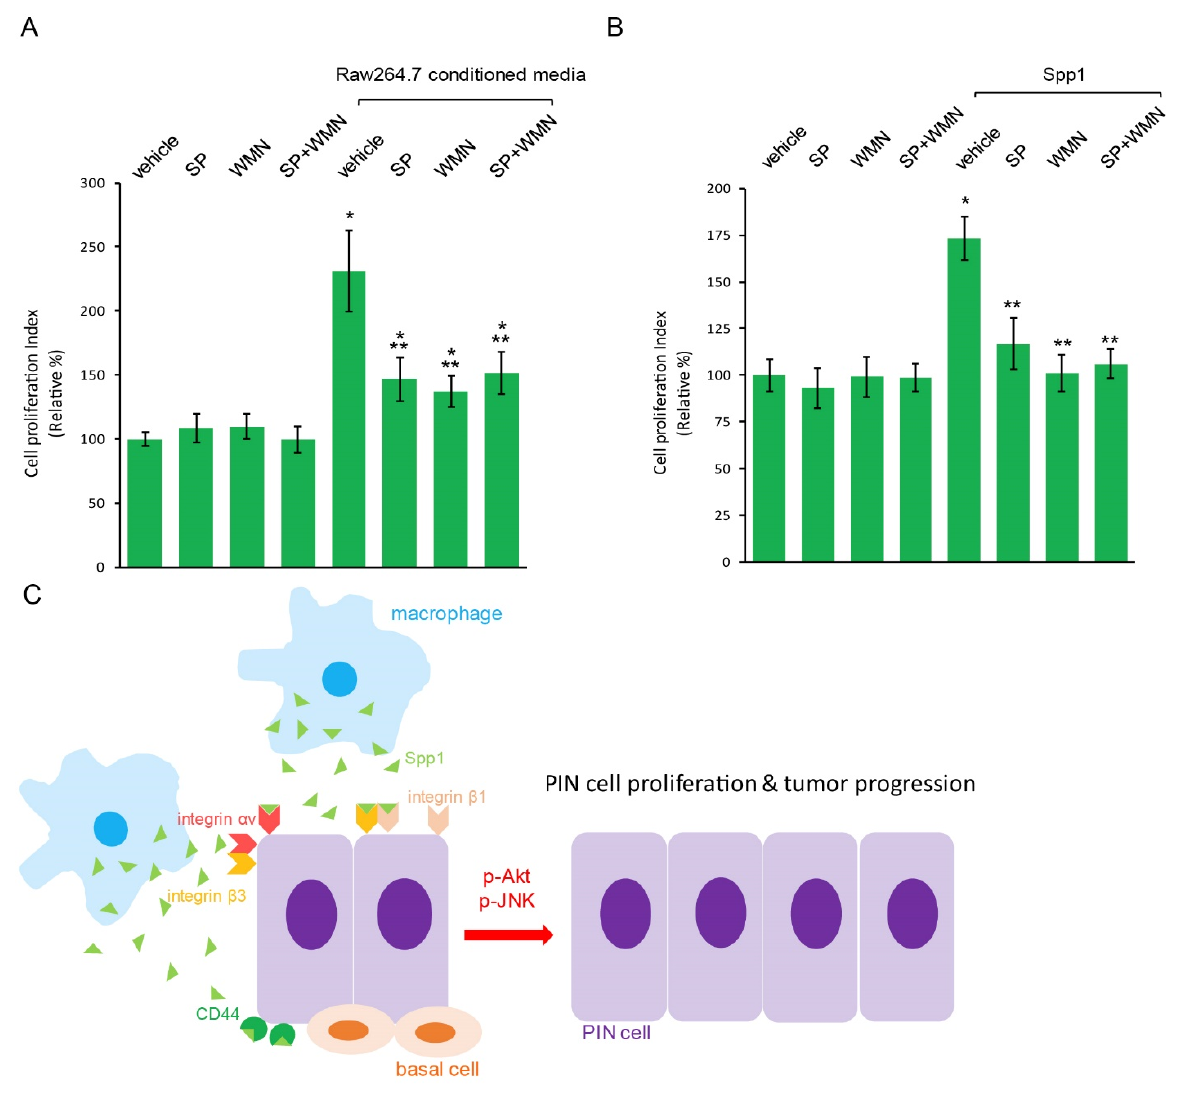
Figure 5. Blockade of Akt and JNK suppressed macrophage Spp1-induced cell proliferation of PIN. ( A , B ) SP600125, a specific JNK inhibitor, and/or Wortmannin, a specific Akt inhibitor, was added to 3D cultures of murine PIN Pr111 cells stimulated with either Raw 264.7-conditioned media ( A ) or recombinant Spp1 ( B ) for 72 h. Vehicle/DMSO was used as a control for SP600125 and Wortmannin; ddH 2 O was used as a control for recombinant Spp1. The cell proliferation index under these conditions was quantified. *: p < 0.05 as compared to the control+vehicle, **: p < 0.05 as compared to vehicle+Raw264.7-conditioned media or Spp1 (-way ANOVA and multiple comparisons), n =